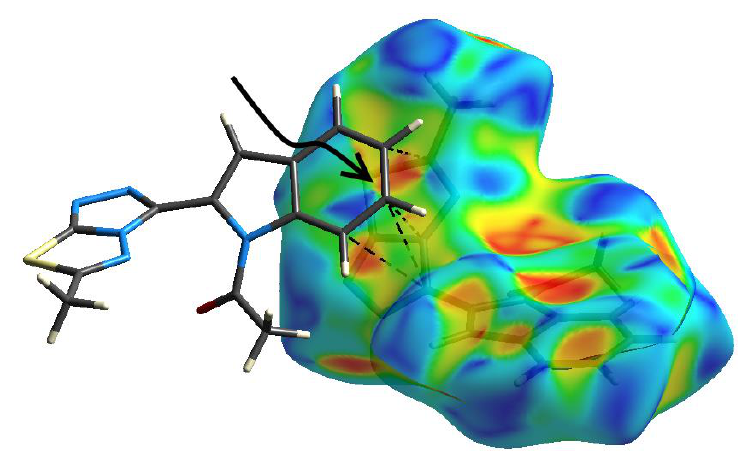
Figure 7. Shape index of the shortest π - π interactions.